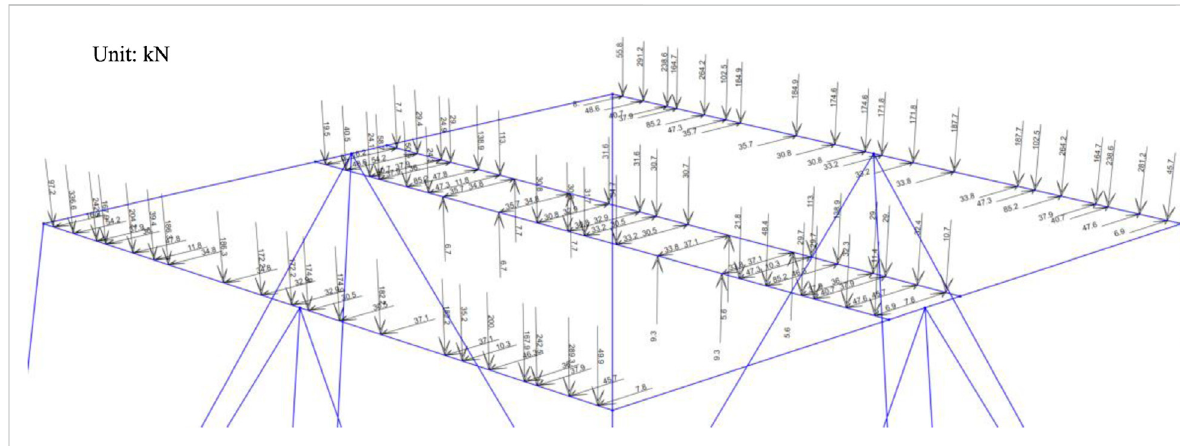
FIGURE 4 Loads applied on the sheave wheel platform under normal working